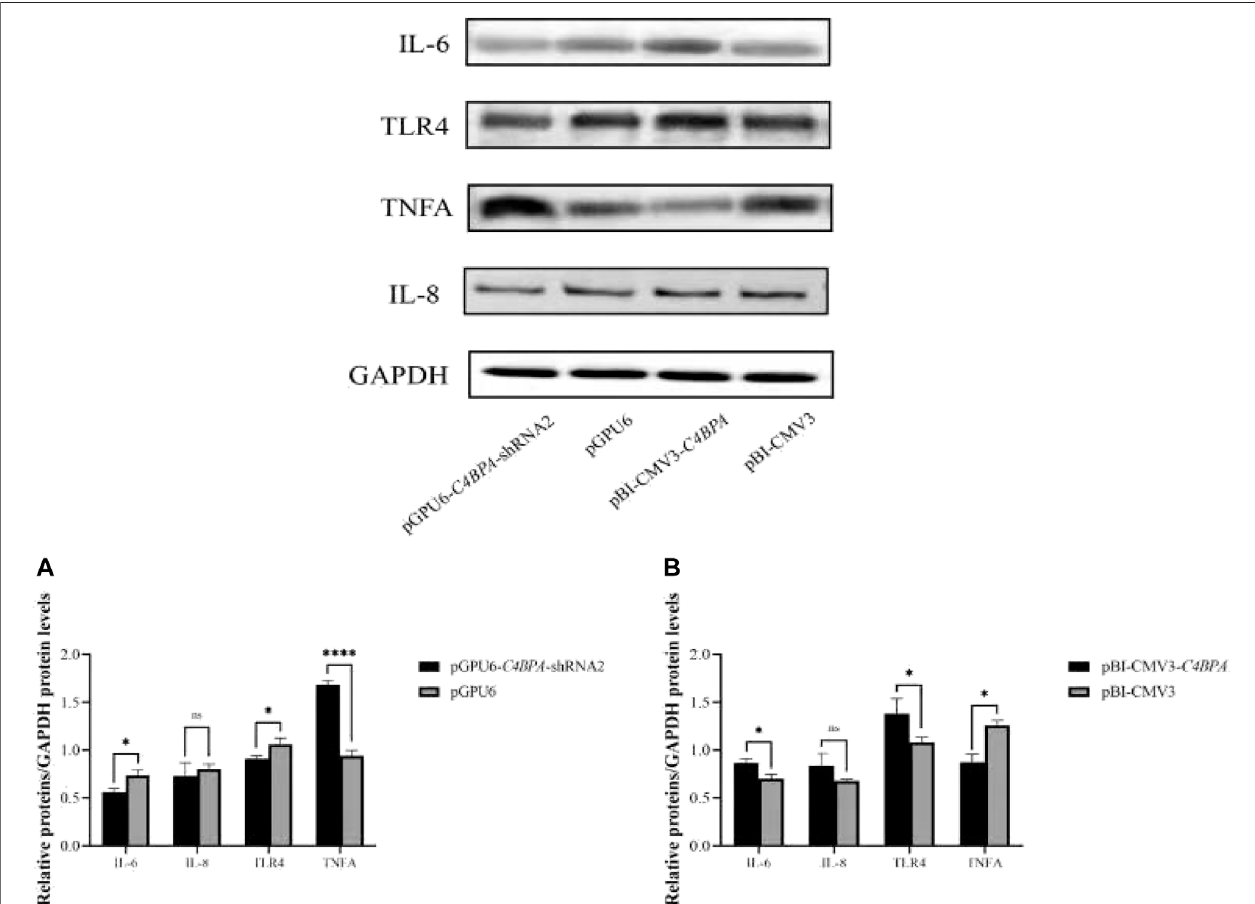
FIGURE6| RelativeproteinexpressionoftheimmunityrelatedfactorsinbMECs. (A) Relativeproteinexpressionofin fl ammatoryfactorsinbMECsaftertransfection with pGPU6 C4BPA-shRNA2 vector. (B) Relative protein expression of in fl ammatory factors in bMECs after transfection with pBI-CMV3-C4BPA vector.